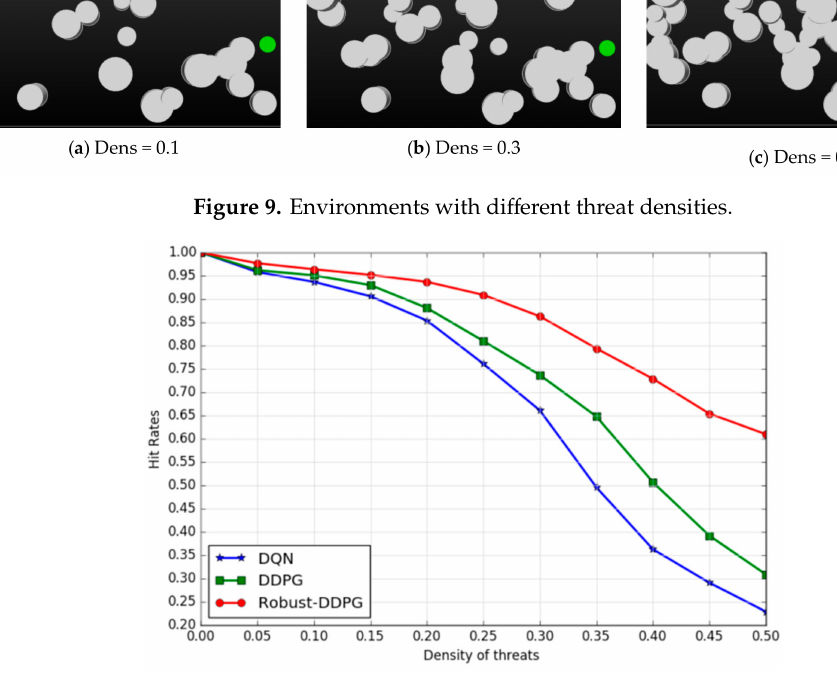
Figure 10. Trends of hit rates under di ff erent threat densities of the three